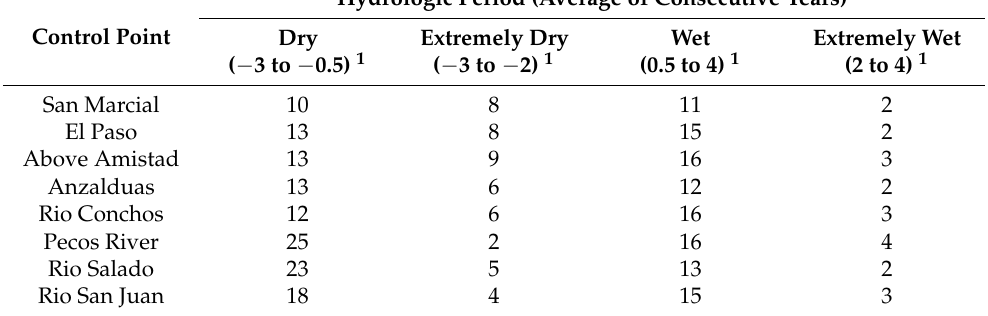
Table 2. Hydrologic periods of the Rio Grande–Bravo basin. Each hydrologic period is the average of the consecutive number of years that ranges from specific SDI values.